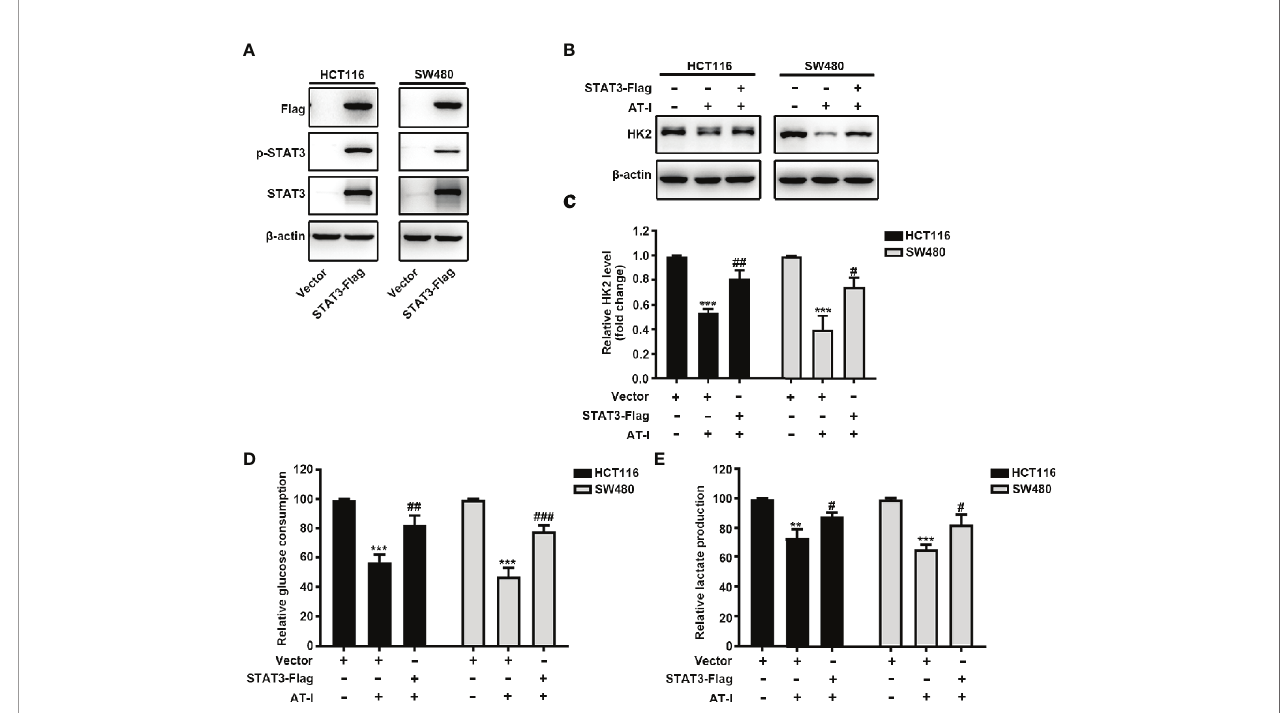
FIGURE 5 | STAT3 inactivation is essential for AT-I-decreased HK2 expression and suppressed glycolysis in CRC cells. (A) The Flag-STAT3 plasmid was transfected into CRC cells, and after 48 h, these cells were treated with AT-I (200 m M) for a further 24 h, followed by western blot analysis to detect Flag, p-STAT3 (Tyr705) and STAT3 expression levels. (B) Western blot analysis of HK2 expression levels was performed for the CRC cells with STAT3 overexpression after AT-I treatment. (C) HK2 protein levels were normalized to those of b -actin and are shown as fold changes. (D) Glucose consumption and (E) lactate production were determined in CRC cells with the indicated treatments. ** p < 0.01 and *** p < 0.001 compared with the control group without any treatment. # p < 0.05, ## p < 0.01 and ### p < 0.001 compared with the AT-I-treated